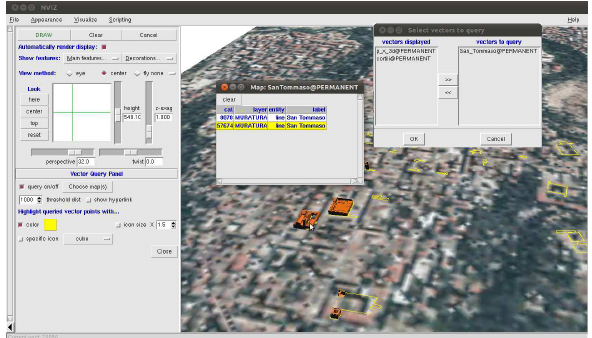
Figure 16. Query at the 3D models in